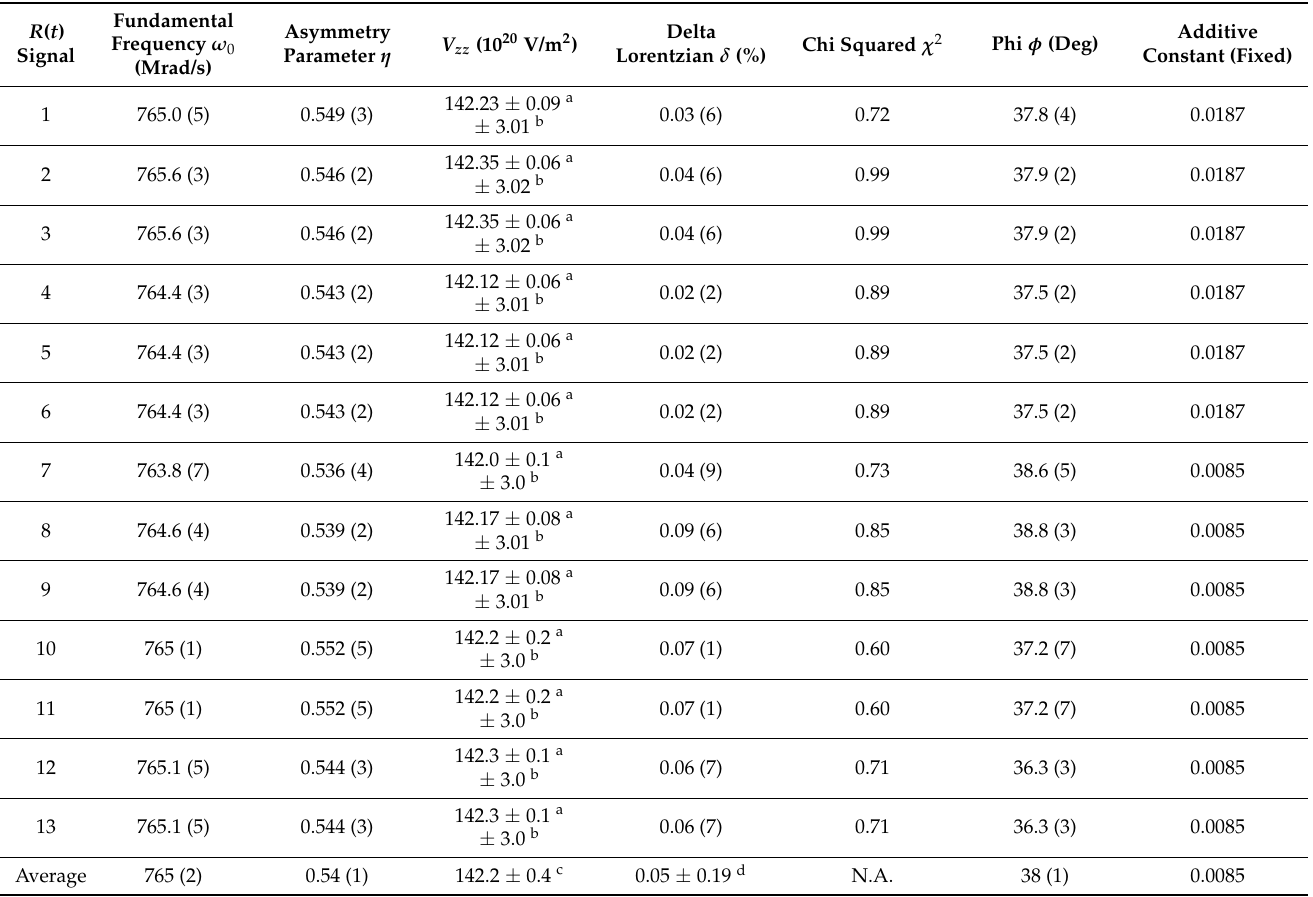
Table 2. Table of fitted hyperfine and experimental parameters for the set of 13 different e − γ TDPAC measurements of 181 Ta(TiO 2 ), returned by the Gfit19 TM program. For the individual values of V zz , the fit uncertainty is separated into (a) the statistical uncertainty caused by our instruments, and (b) the (dominant) systematic uncertainty of the quadrupole moment ( ± 2.1%) as quoted in reference [51]. Compared with the single γ − γ TDPAC measurement of 181 Ta(TiO 2 ) with four different geometries (Table 1), the multiplicative constant and additive constant of this set of e − γ TDPAC measurements is fixed at 1 and 0.0187 or 0.0085, respectively. The averaged values of ω 0 , η , and V zz from this set of e − γ TDPAC measurements were calculated, with (in the case of V zz , (c)) the uncertainty assigned the square root of the sum of squares of their statistical uncertainty (in the case of V zz , (a)). (d) The averaged δ is written in this form, as its uncertainty exceeds its